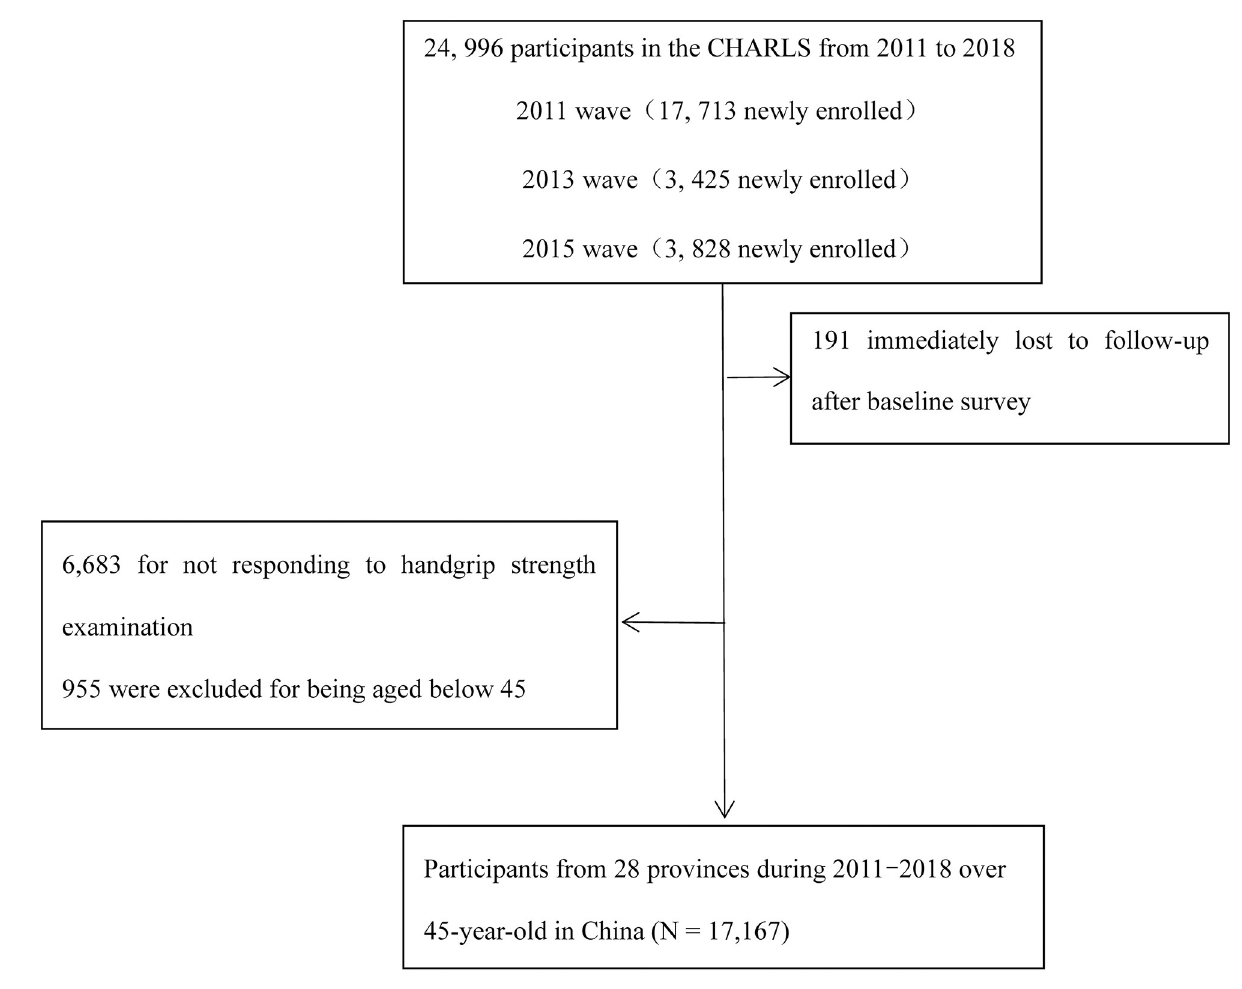
Fig 1. Flowchart of subject recruitment and